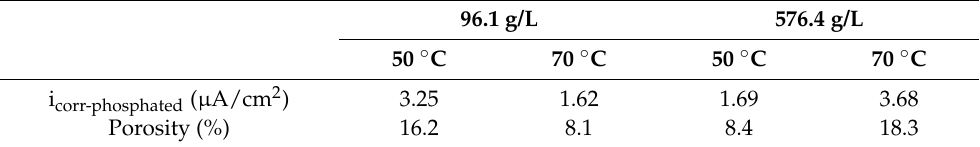
Table 8. Quantitative EDS analysis (atomic%) of the phosphate layers obtained after the pickling in citric acid.